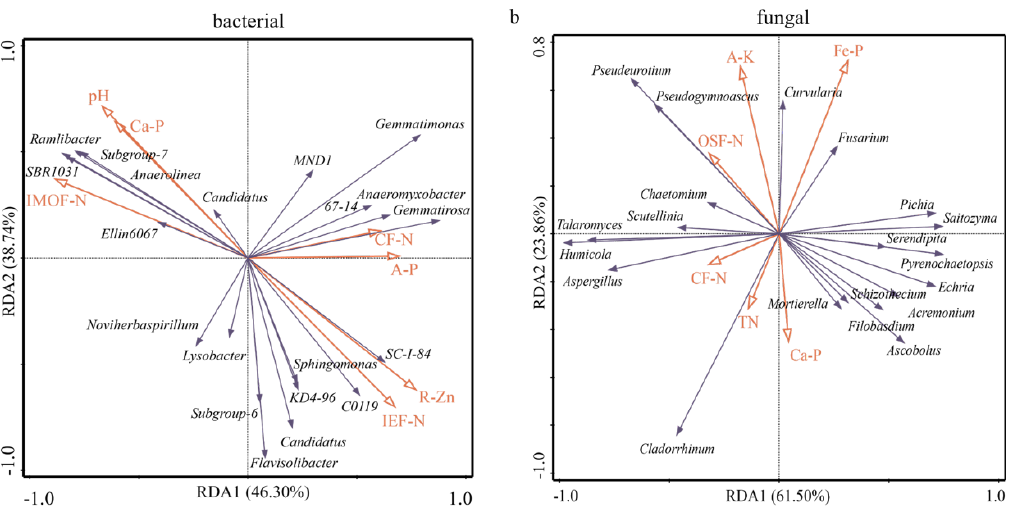
Figure 7. Redundancy analysis (RDA) of bacterial ( a ) and fungal ( b ) communities in rice rhizosphere soil. RDA correlation plot showed variance in genera of bacterial and fungal explained by soil chemical factors. EF-N, ion exchanged nitrogen; CF-N, carbonate bounded nitrogen; IMOF-N, iron-manganese oxide nitrogen; OSF-N, organic sulfide bounded nitrogen; T-N, total nitrogen; A-P, available P; Fe-P, iron bound P; Ca-P, calcium bound P; A-K, available potassium; R-Zn, solid residue zinc.